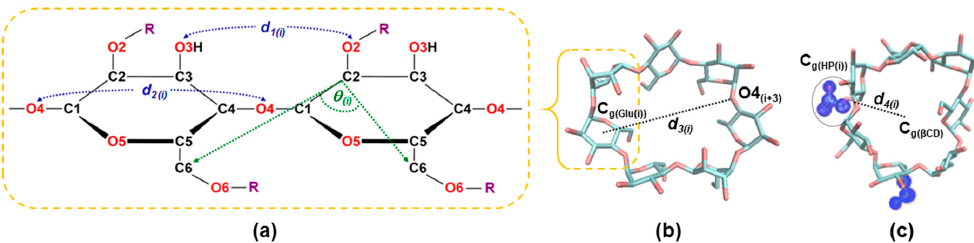
Figure 3. ( a ) Cyclodextrin (CD) fragment showing the atomic labels and important structural parameters, d 1(i) [O2 (i) –O3 (i+1) ], d 2(i) [O4 (i) –O4 (i+1) ], and θ (i) [C6 (i) –C2 (i+1) –C6 (i+1) ]. ( b ) Set of diameters, d 3(i) [C g(Glu(i)) –O4 (i+3) ], for circularity. ( c ) Set of d 4(i) [C g( β CD) –C g(HP(i)) ] for studying cavity self-closure.